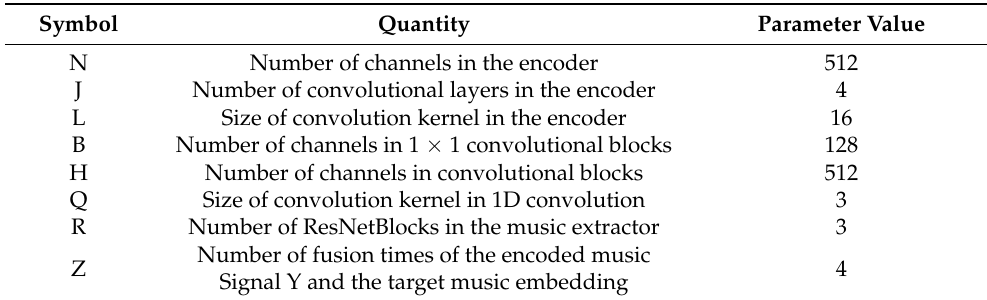
Table 1. Training model parameter setting.